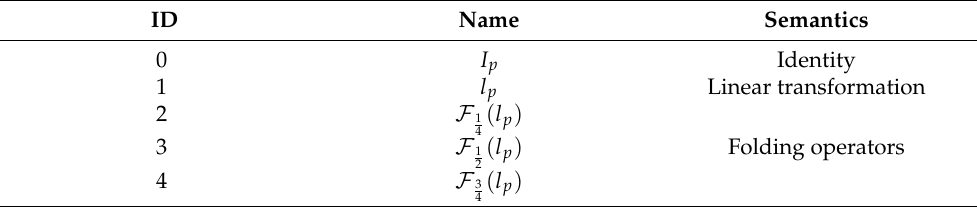
Table 2. Basis functions used to define